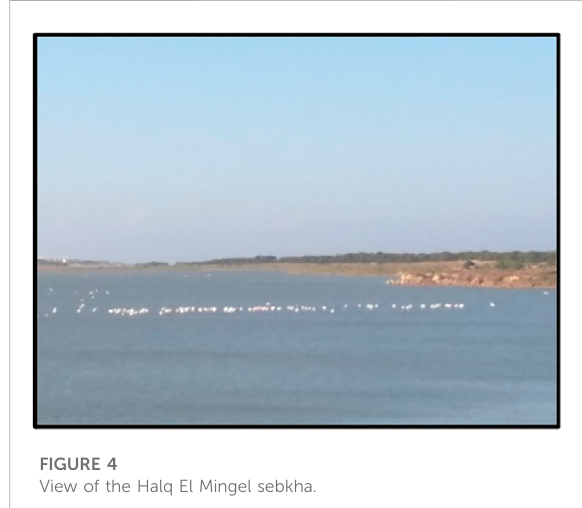
FIGURE 3 View of the El Madfoun forest.